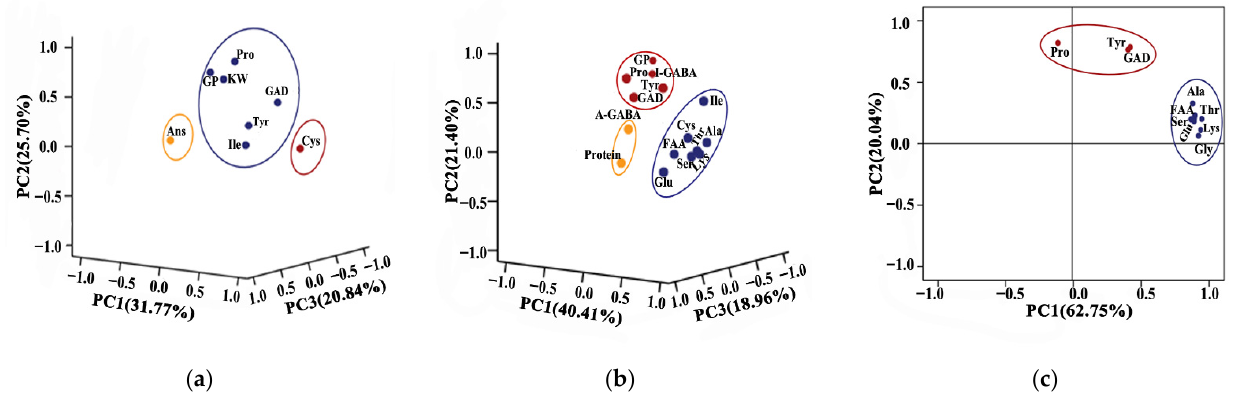
Figure 7. Principal component analysis. ( a ) Loading plot of PC1, PC2, and PC3, from parameters that significantly correlated with I ‐ GABA; ( b ) loading plot of PC1, PC2 ,and PC3, from parameters that significantly correlated with P ‐ GABA; and ( c ) loading plot of PC1 and PC2, from parameters that significantly correlated with A ‐ GABA.